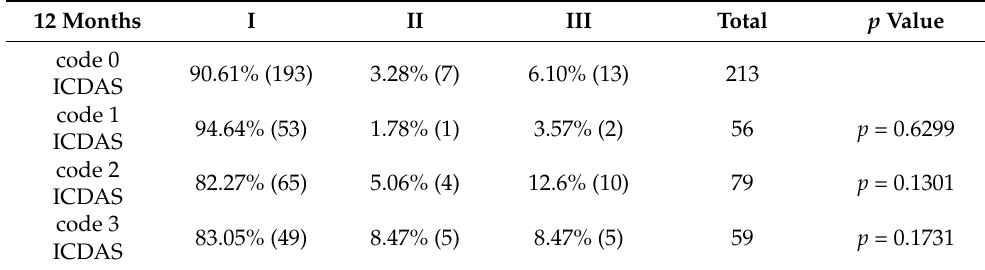
Table 3. Retention based on Simonsen’s criteria at the 12-month follow-up.